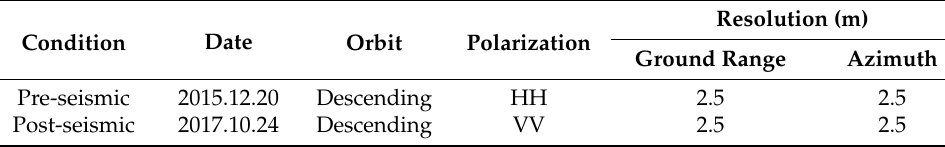
Table 1. Acquisition information of temporal Kompsat-5 data set.